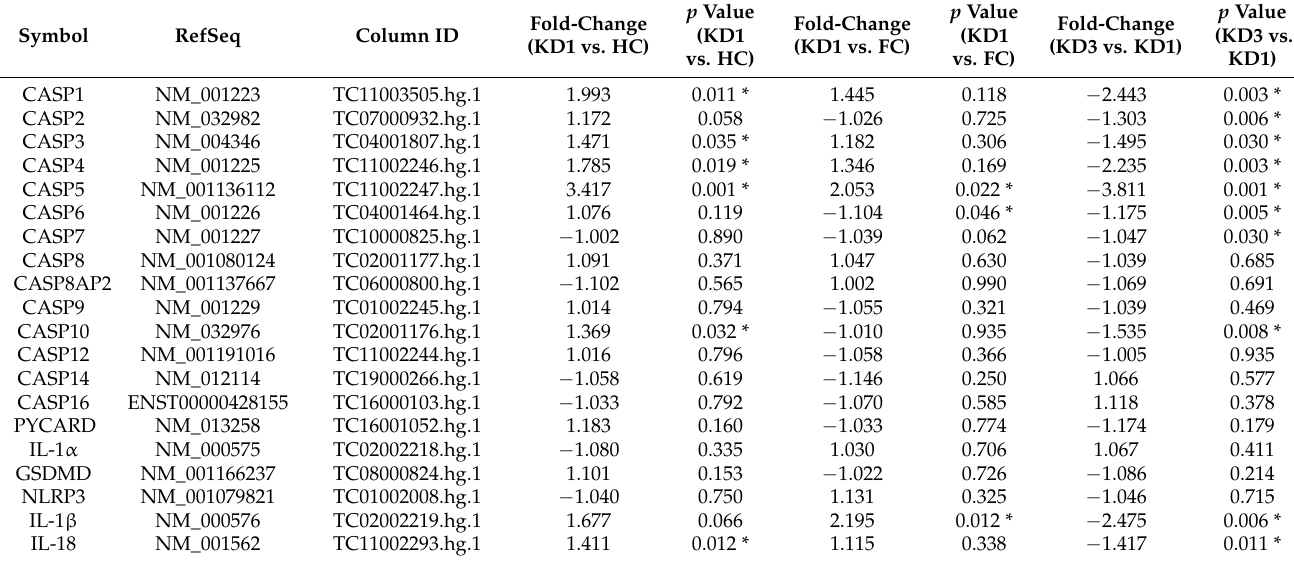
Table 2. Transcript expressions of caspases (CASPs) between Kawasaki disease patients and control subjects.